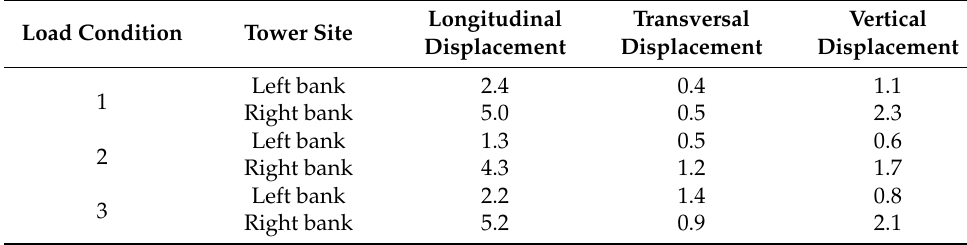
Table 7. Maximum displacement error at tower top (unit: mm). Load